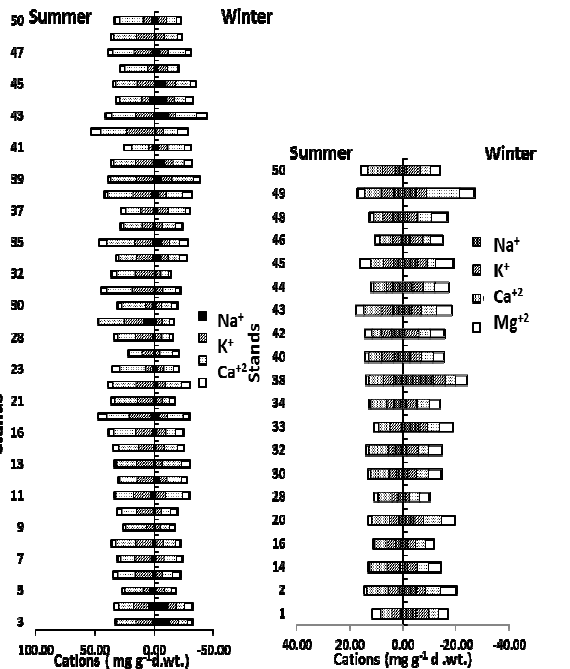
Fig. 6. Concentrations of Cl- (in mg g-1d.wt.) and SO4-2 and PO4-3 (in µgm g-1 d.wt.) in Zilla spinosa and Leptadenia pyrotechnica plants collected from different studied stands in summer and winter